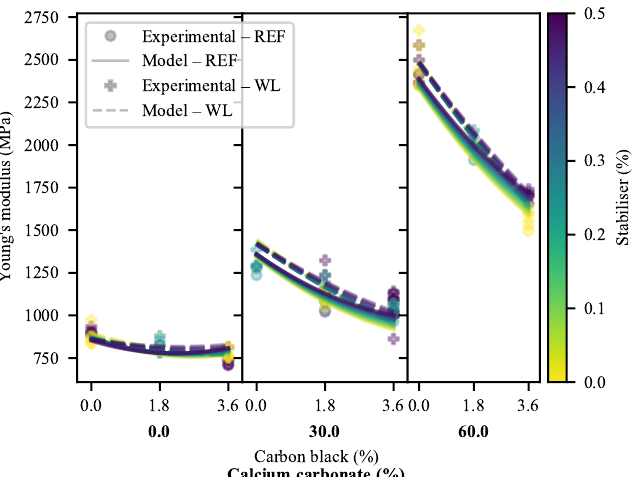
Figure 2. Influence of the specimen type and loadings of calcium carbonate, carbon black and the stabiliser package on the experimentally determined stiffness of the system with fitted models. Specific attention is drawn to the stepped increases in YM and the increasingly negative slopes as a function of CB with increasing